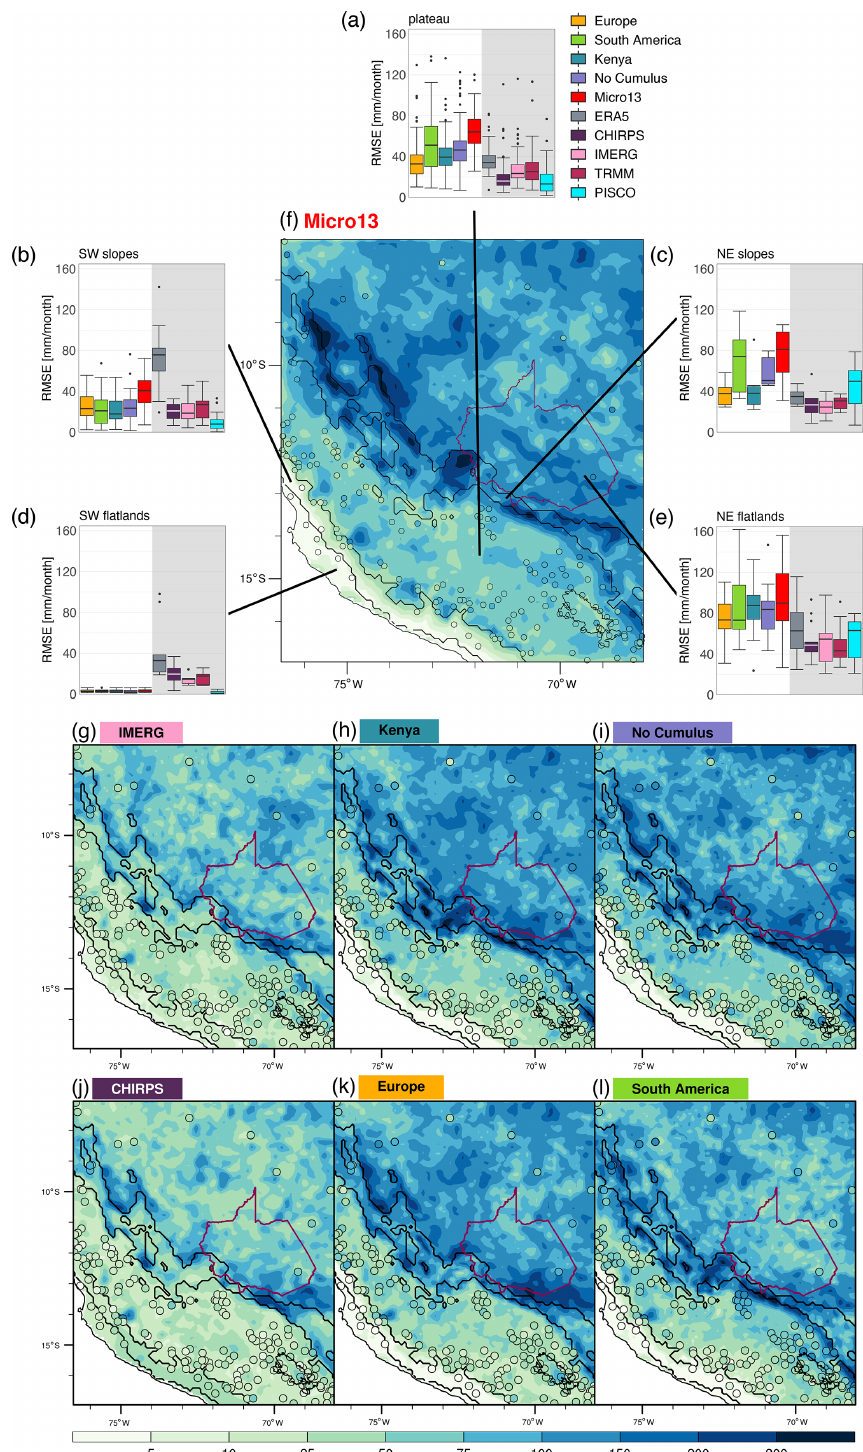
Figure 4. Same as Fig. 3 but for RMSE (in millimetres per